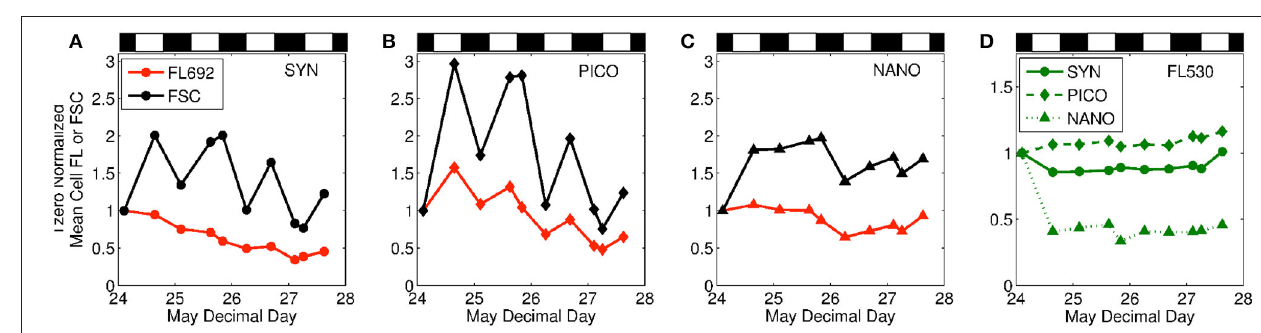
FIGURE 7 | Mean cell fluorescence at 692nm and forward scatter for surface samples of (A) Synechococcus , (B) picophytoplankton, (C) nanophytoplankton, and (D) mean cell fluorescence at 530nm for all groups at the surface.